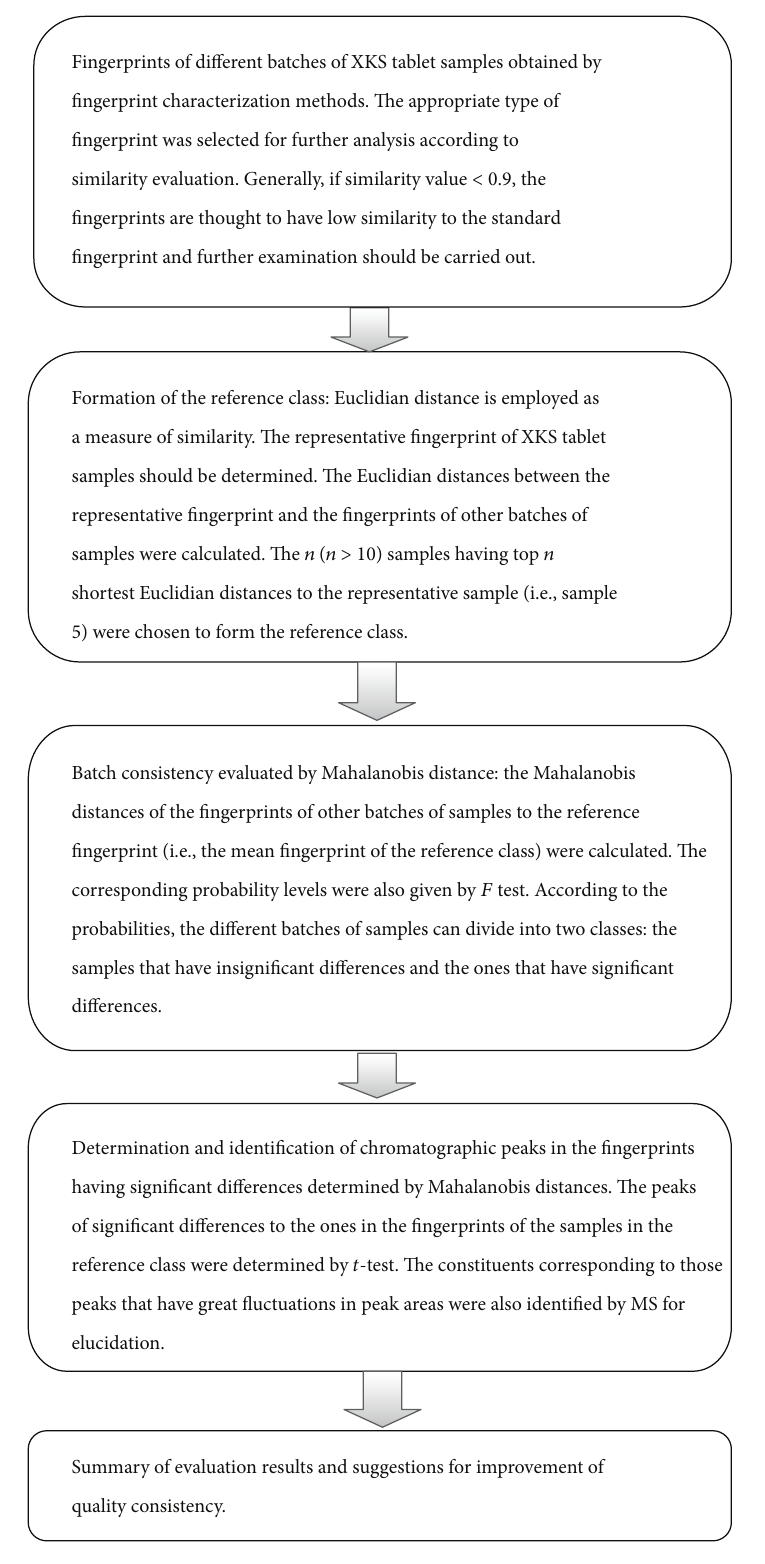
Figure 8: A strategy for the consistency evaluation of different batches of XKS tablet